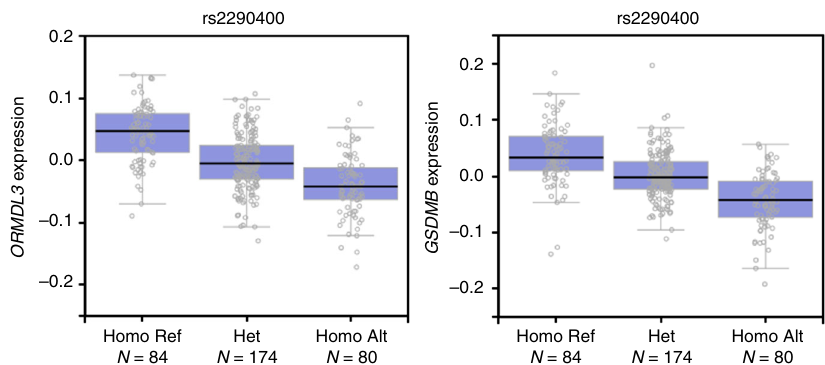
Fig. 4 GTEX expression quantitative trait analysis of rs2290400 (chromosome 17, reference allele T, alternative allele C). Data from whole blood samples are shown, the signi fi cance of the eQTL was lower than a P value of 10 − 25 for both genes. Box plots depict the interquartile range, and error bars indicate 1.5 times the interquartile